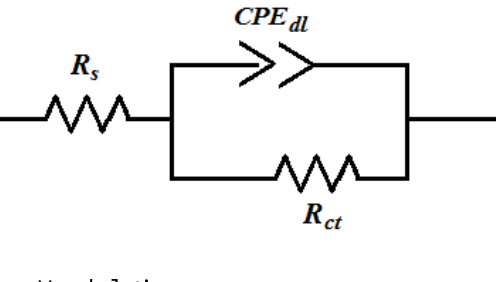
Figure 7. Equivalent model used to fit the impedance data for mild steel in 1.0 M HCl in the absence and the presence of PMBH.